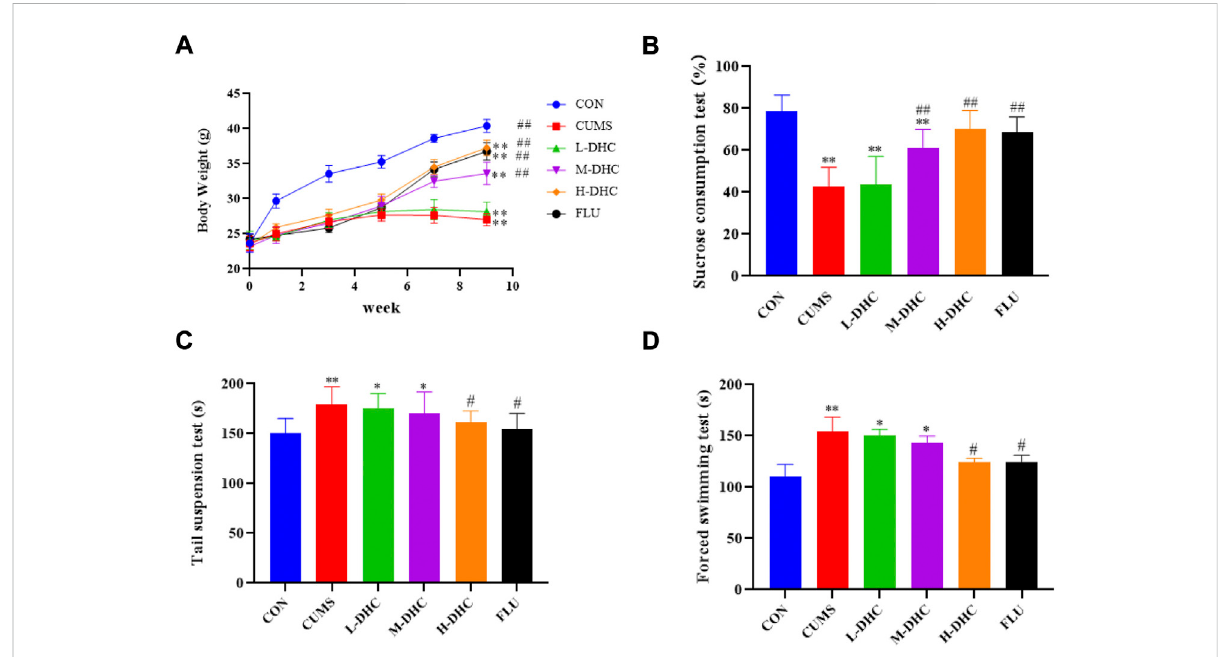
FIGURE 1 Effects of DHC or fl uoxetine on body weight and desperate behavior of CUMS-induced depression in mice. (A) Body weight, (B) sucrose preference test (SPT), (C) tail suspension test (TST), and (D) forced swimming test (FST). * p < 0.05 and ** p < 0.01, compared with the control (CON) group; # p < 0.05 and ## p < 0.01, compared with the CUMS